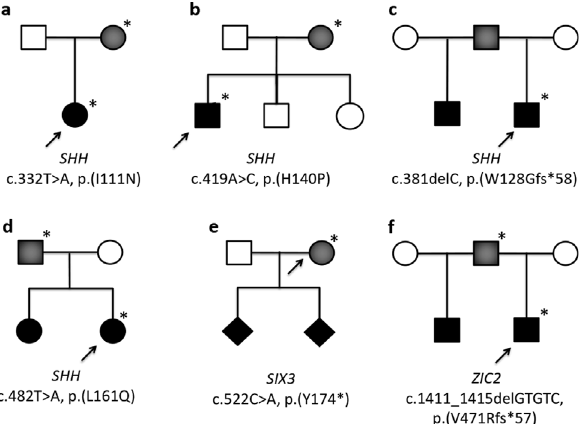
Figure 1 - The pedigrees of families with segregating mutations in HPE genes.FilledsymbolsindicatefrankHPE;partiallyfilledsymbolsindicate HPE microforms; asterisks indicate mutation carriers confirmed through sequencing; and arrows indicate